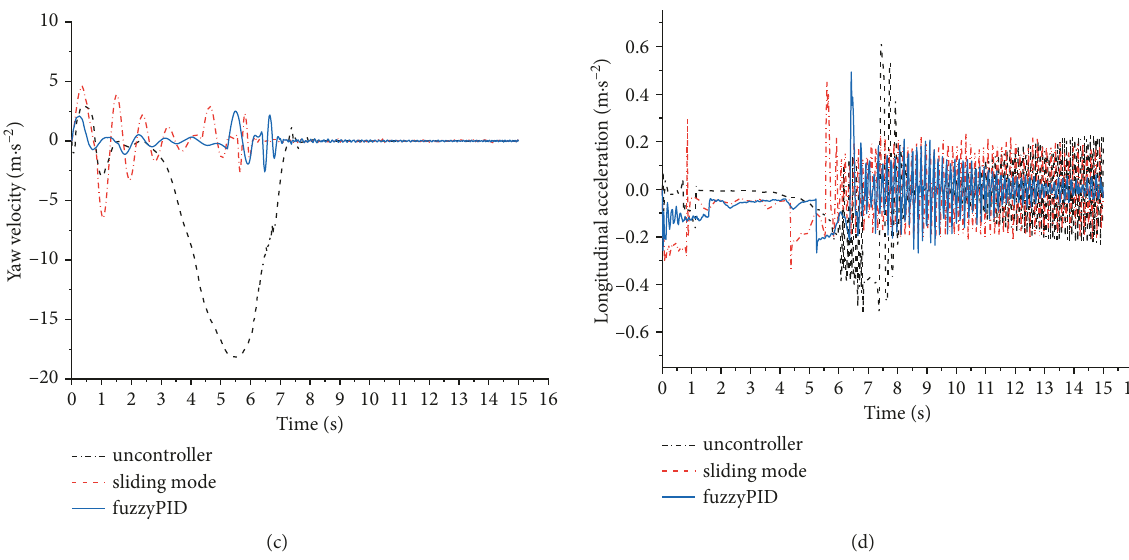
Figure 18: Simulation comparison diagram of different controls in curve driving with u � 0.9. (a) Braking distance. (b) Lateral acceleration. (c) Yaw velocity. (d) Longitudinal